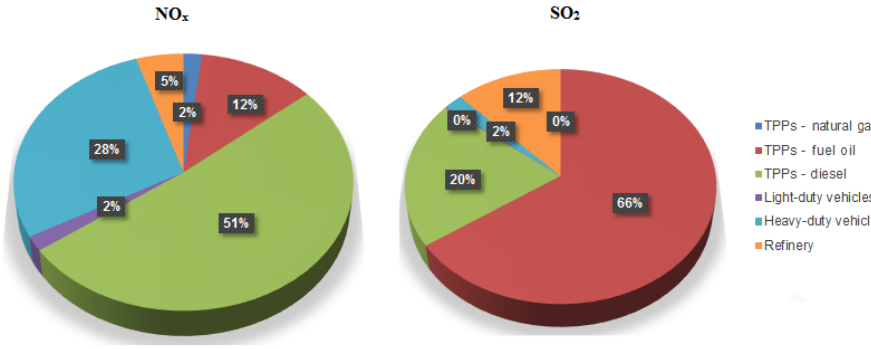
Figure 3. NO x and SO 2 emission contribution from all anthropogenic sectors